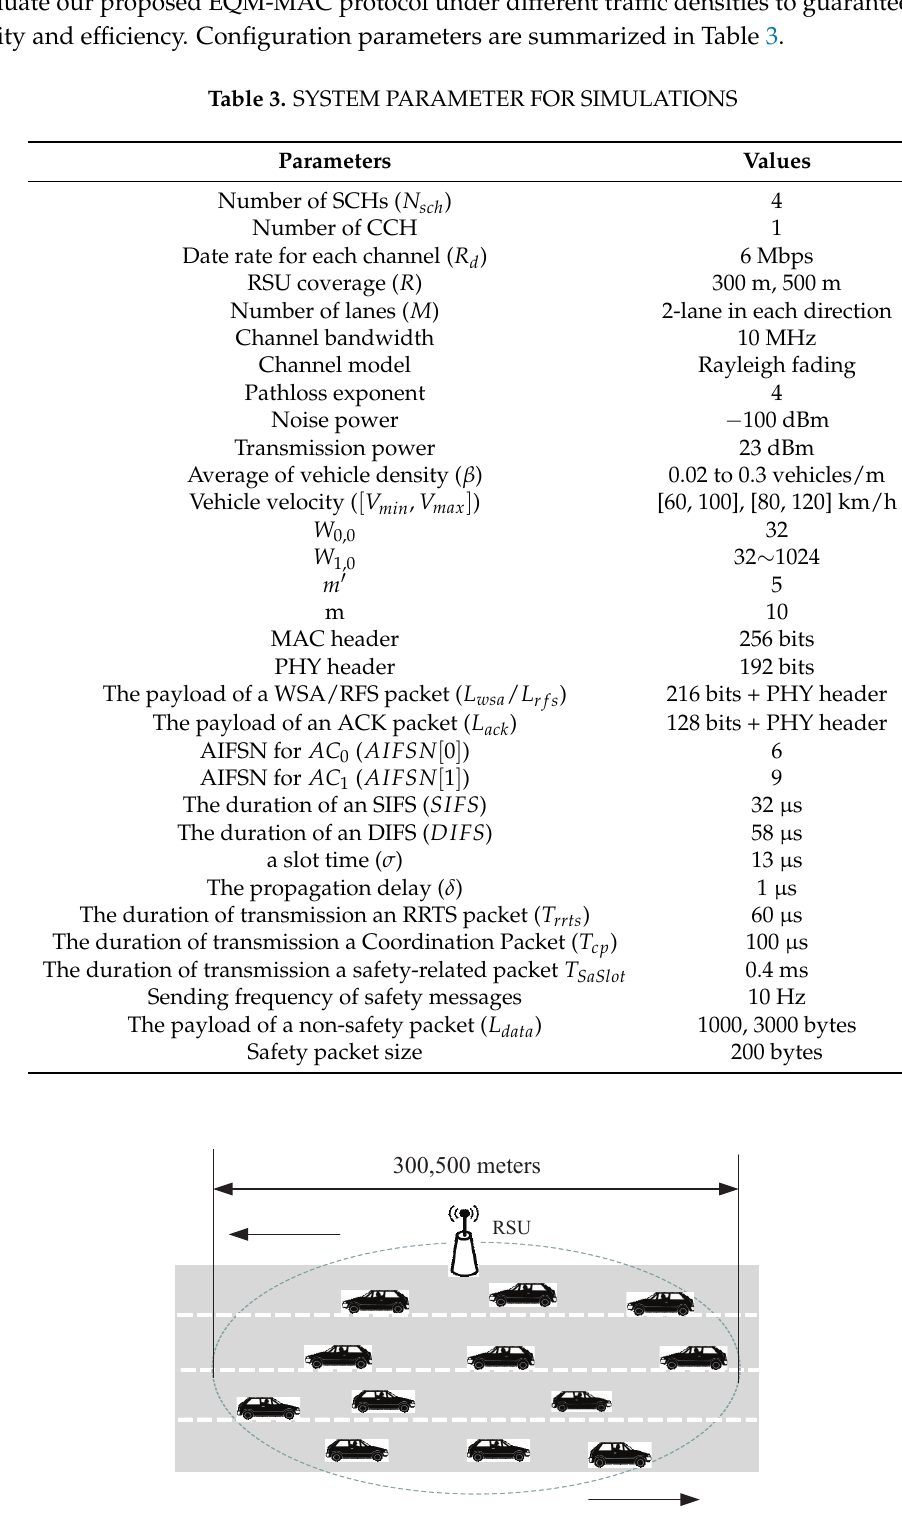
Figure 3. A scenario with 2 lanes in each direction on highway with RSU and moving